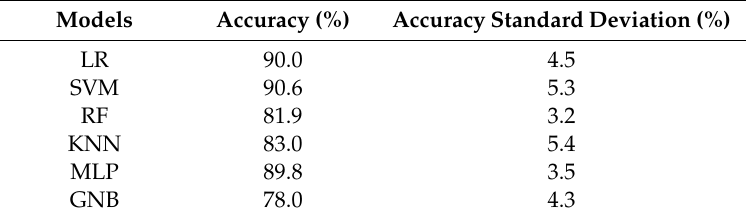
Table 4. The data test with di ff erent deep learning